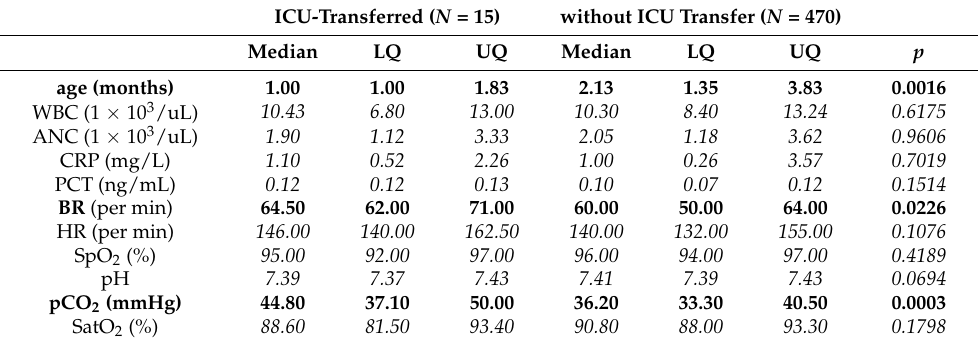
Table 1. Baseline characteristics of patients transferred and not transferred to an ICU.